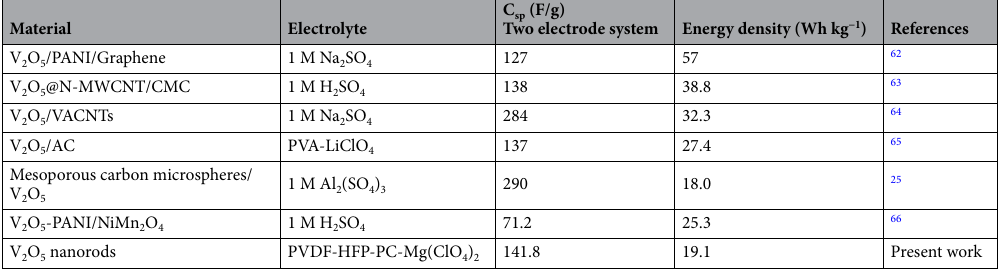
Table 3. Electrochemical comparison of present work with recent supercapacitor